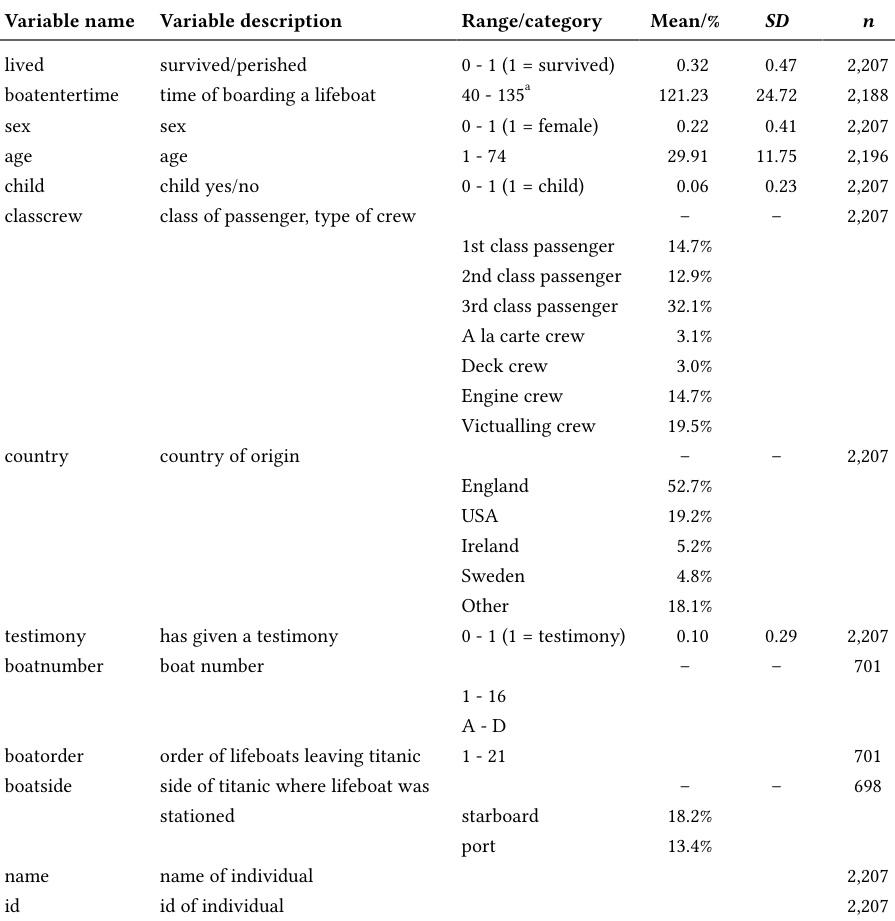
Descriptive Information on the Quantitative Titanic Dataset (Selection of